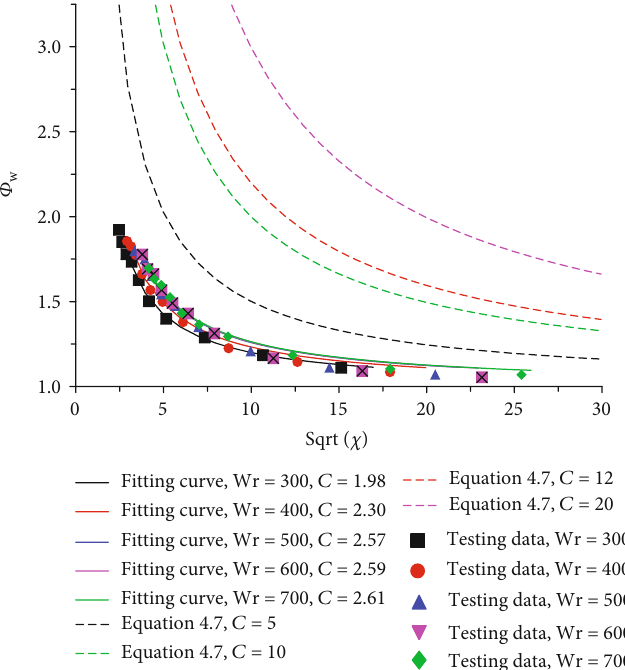
Figure 15: The relationship between Φ